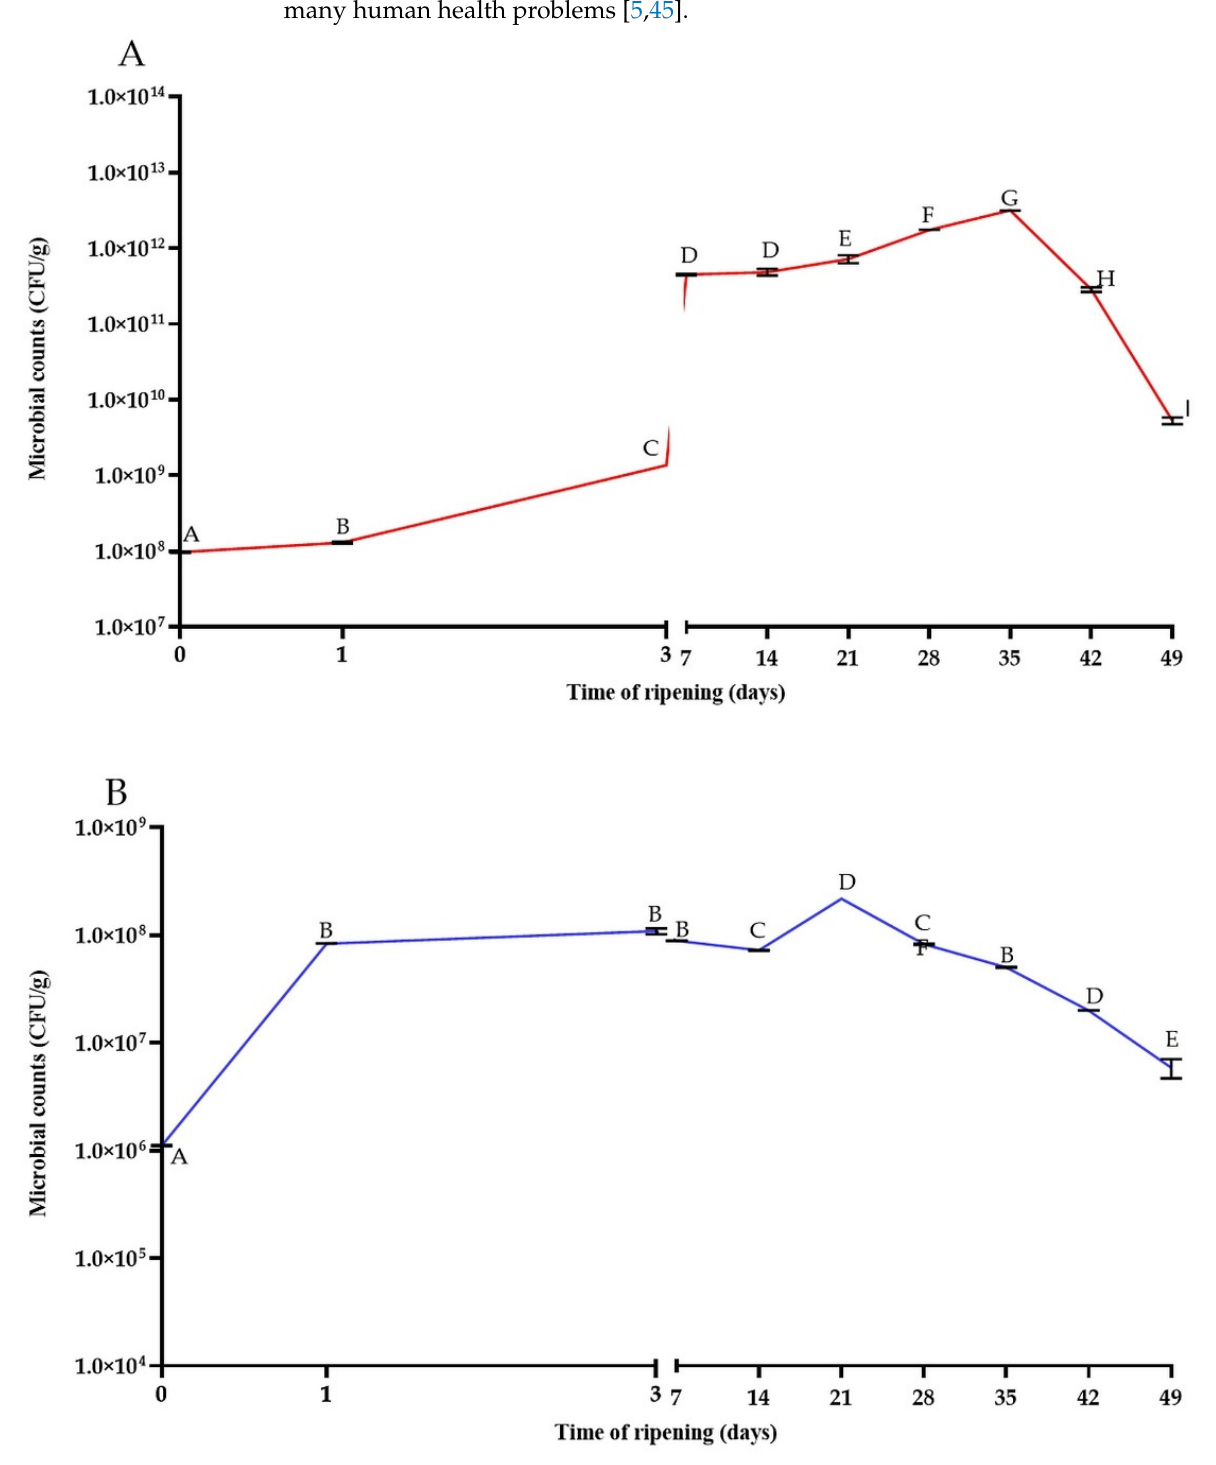
Figure 1. The lactic acid bacteria ( A ) and yeasts ( B ) viability during ripening. Means with different letters (A–I) are significantly different at p < 0.05.